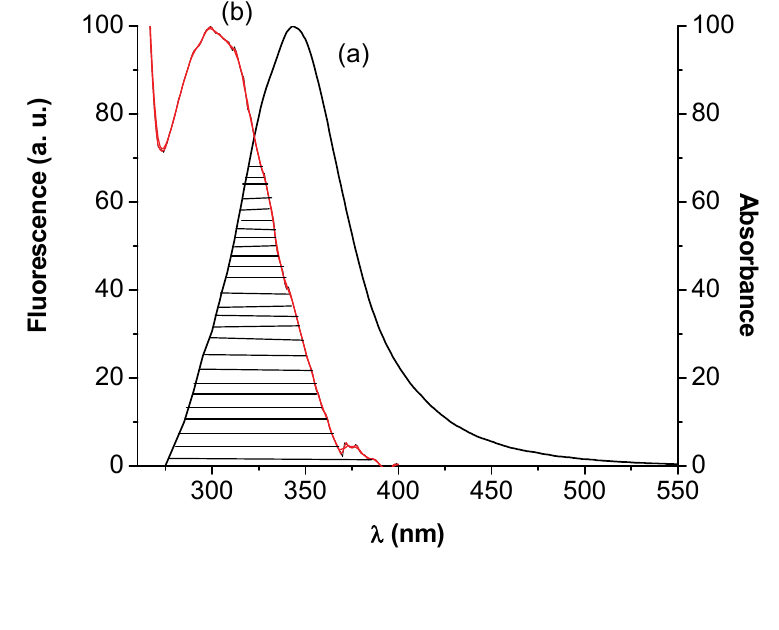
Figure 8. The overlap of the fluorescence spectrum of HSA (a) and the absorption spectrum of I (b)